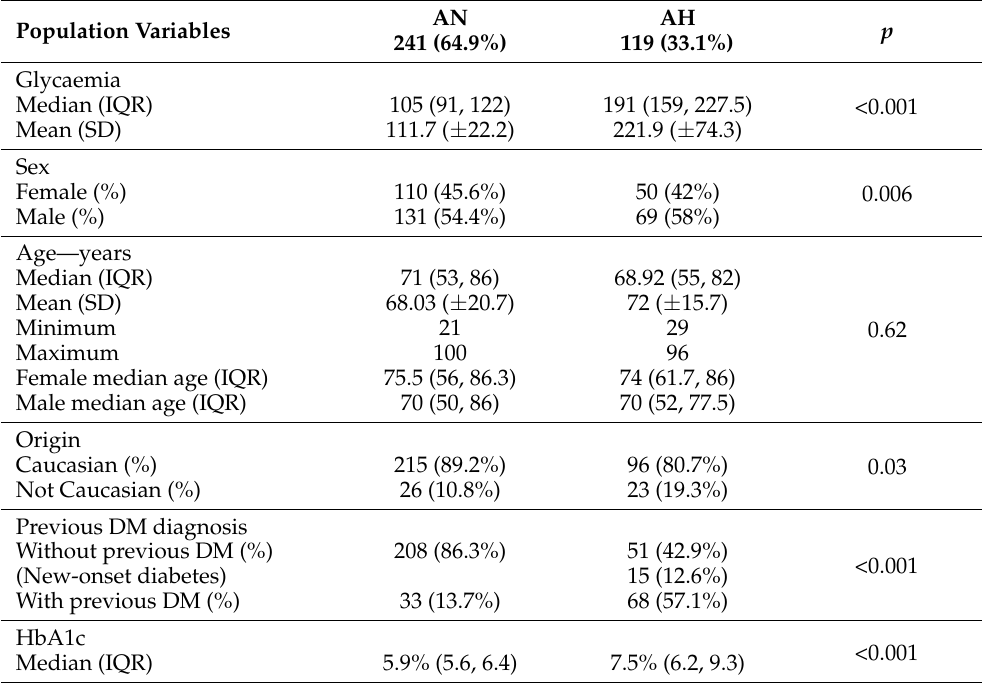
Table 2. Demographic and clinical variables of COVID-19